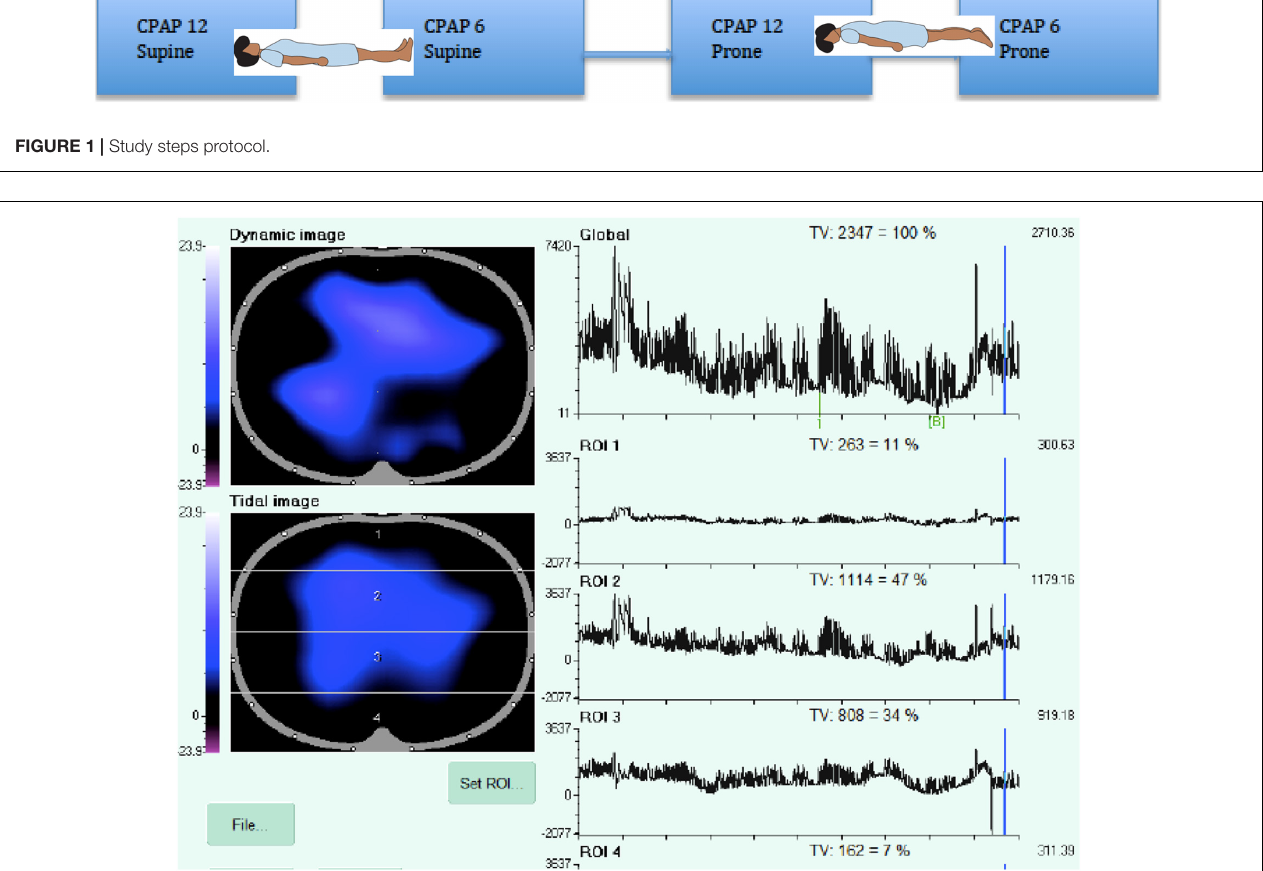
FIGURE 2 | EIT ventilation dynamic distribution image from one CPAP decremental trial. The screenshot shows the distribution of the tidal volume in a cross sectional full screen view of the patient thorax in the caudal-cranial